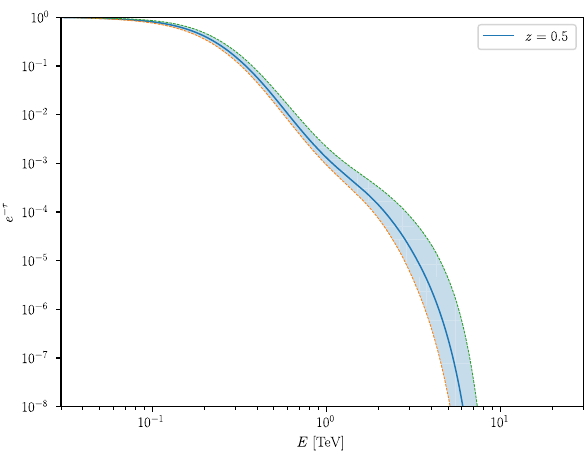
Fig. 8 The EBL attenuation ( e − τ ) of photons from a source with red- shift z = 2 . 0. The model and data are taken from Ref. [50] and http://